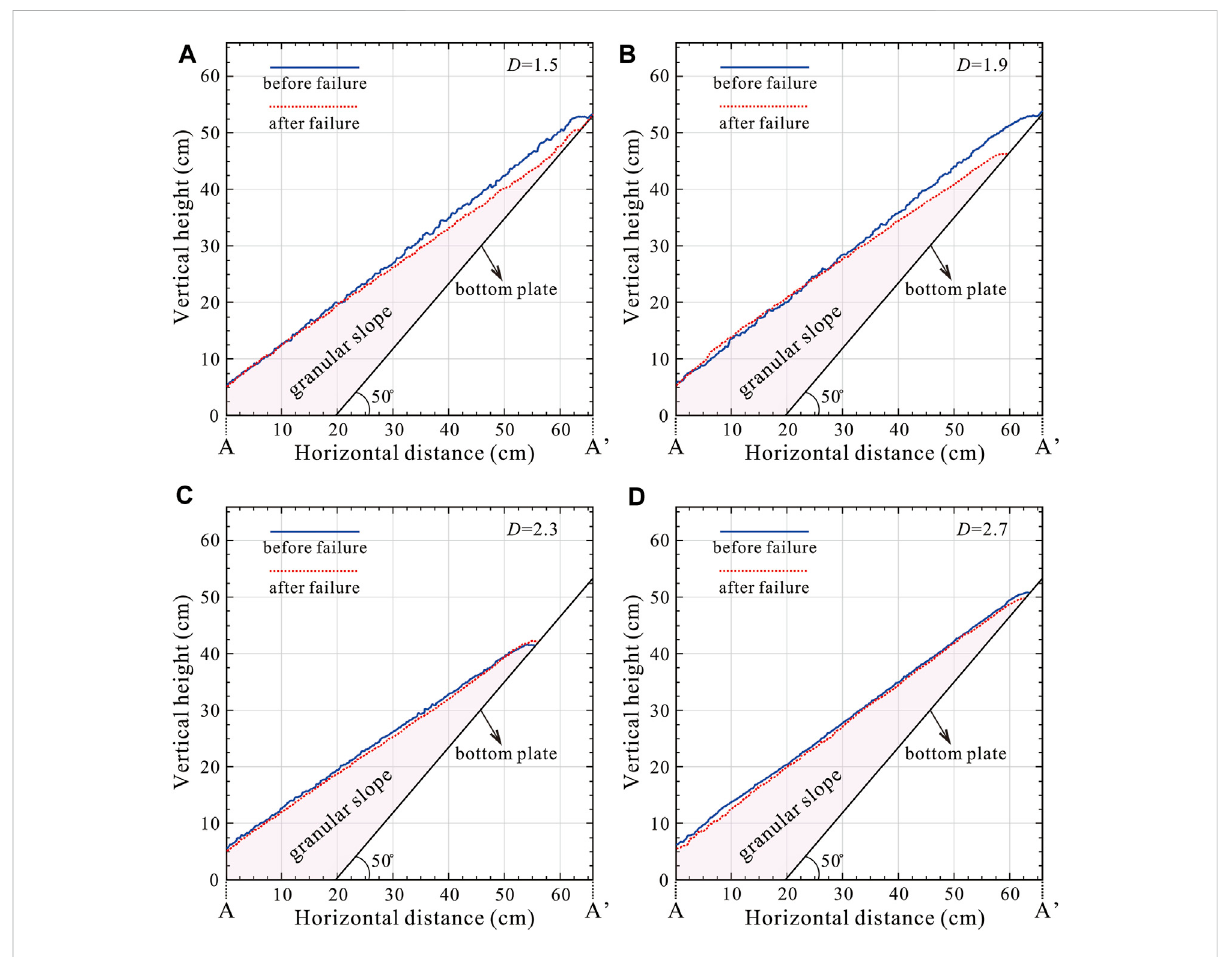
FIGURE 7 Longitudinal sectionsfor granular slopes with different fractal dimensions before and after sur fi cial failure (A) D = 1.5; (B) D = 1.9; (C) D =2.3; (D) D =